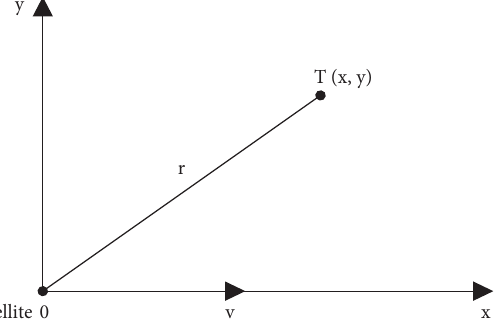
Figure 3: Schematic diagram of a planar motion scene.